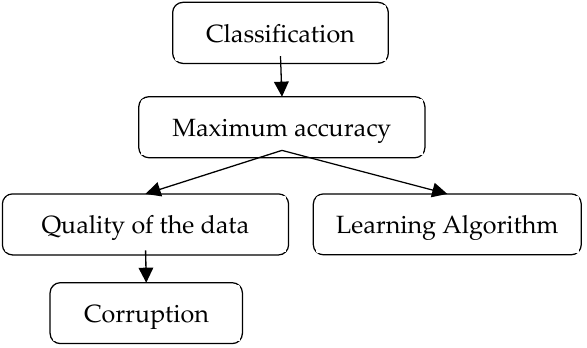
Figure 3. Effect of inappropriate, duplicate, or noisy data on machine learning.